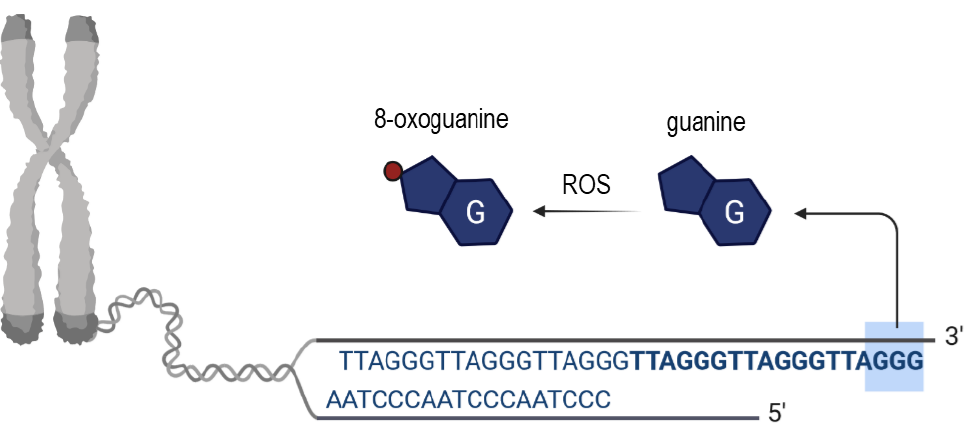
Figure 3. Scheme showing the origin and consequences of oxidative telomeric DNA base damage. Upon ROS the in situ oxidation of a guanine DNA base takes place leading to the generation of 8-oxoguanine (place of oxidation depicted as red dot).